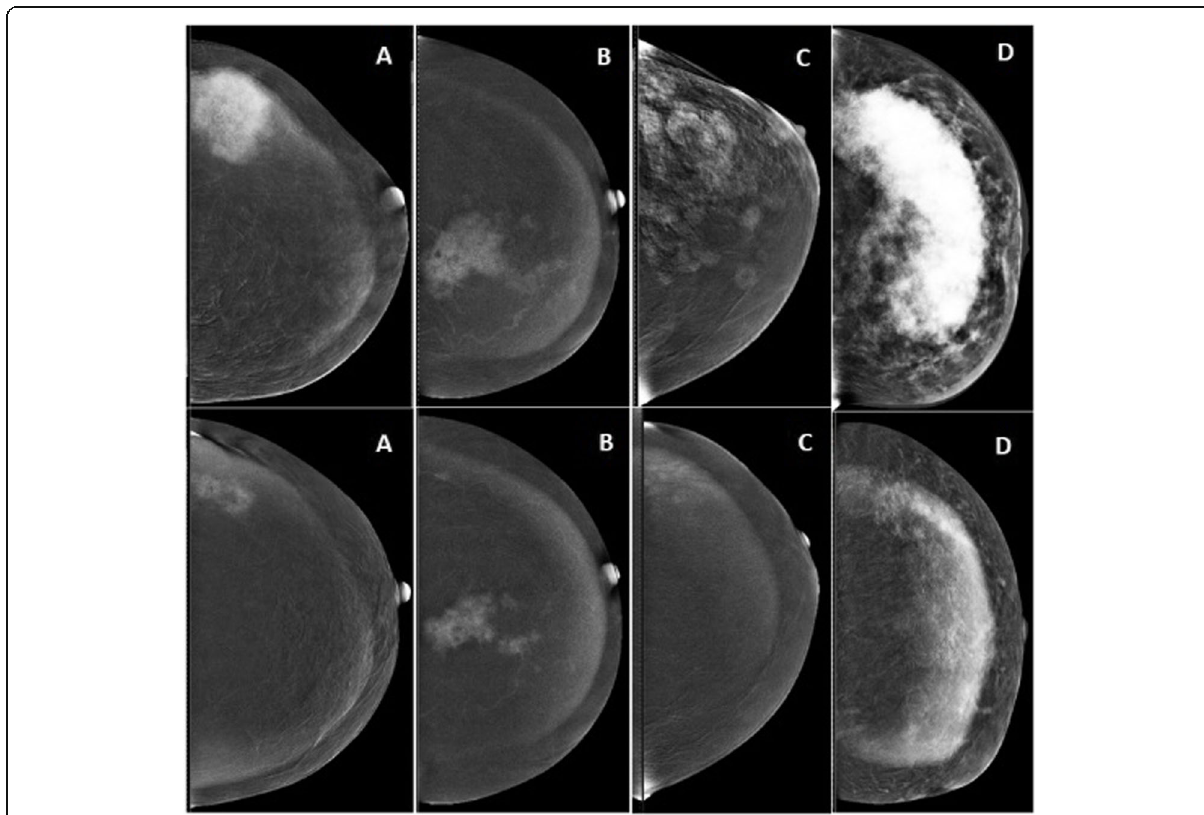
Fig. 2 Different cases showing baseline enhancement patterns and post NAC shrinkage patterns. a Solitary lesion showing type 1 concentric shrinkage. b Grouped lesion showing type 2 concentric shrinkage. c Separated lesion showing type 3 shrinkage. d Replaced lesion showing type 4